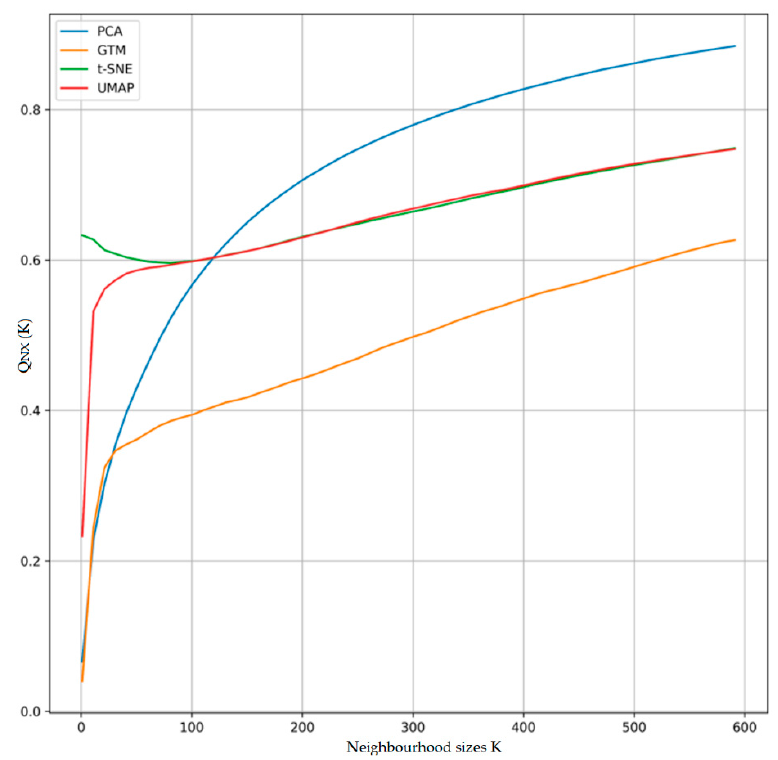
Figure 5. Q NX visualization quantification curves PCA, GTM, t-SNE and UMAP. PCA provides better global patterns (K > 120), whereas, GTM performance is poor in comparison. Further, t-SNE captures the local structures better (K < 120) and UMAP captures better global structure between (250 < K < 550). Table 2. Visualization quantification index (Q NX ) for DRTs against neighborhood sizes (K).